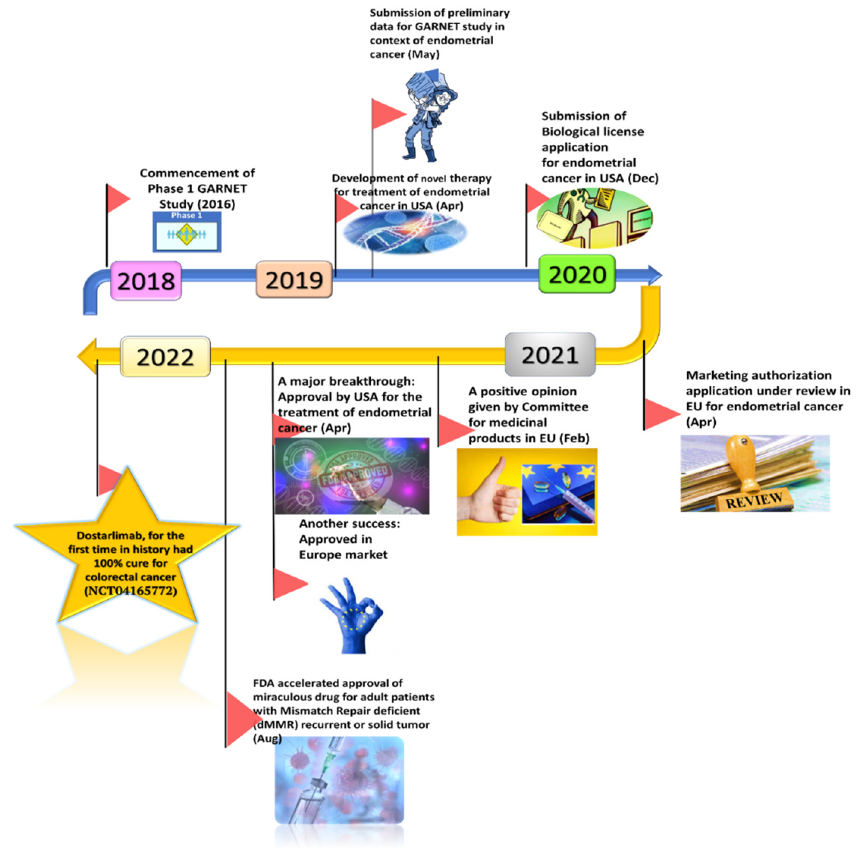
Figure 2. Major milestones of dostarlimab against cancer.